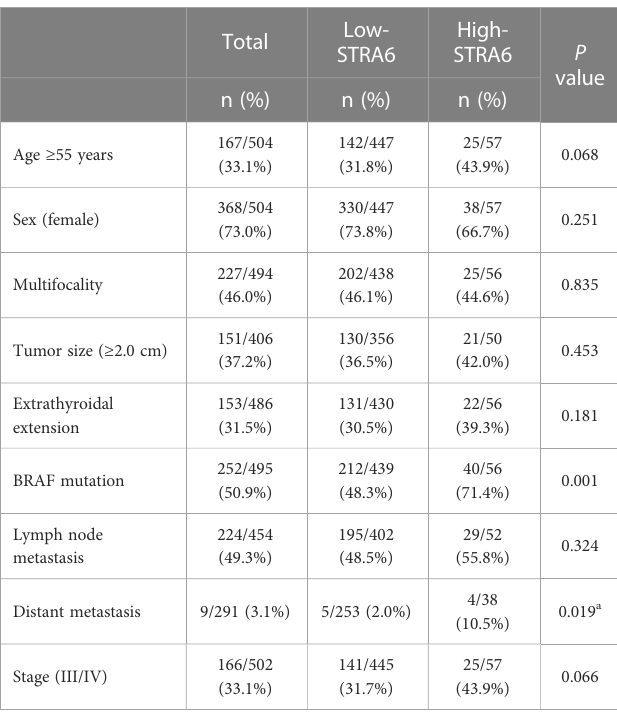
TABLE 1 The association between STRA6 expression and clinicopathologic characteristics in the TCGA